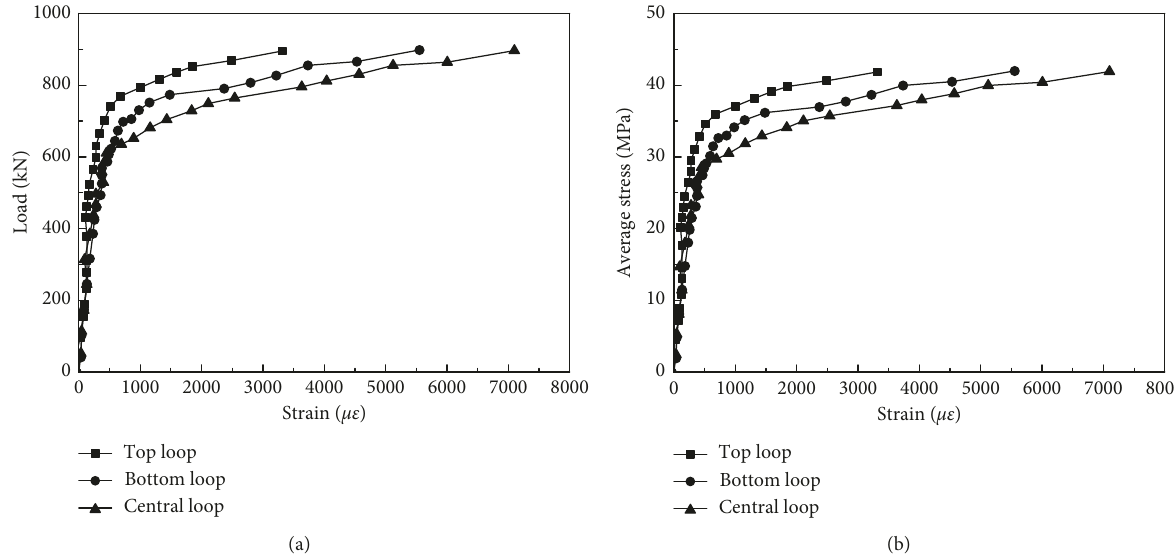
Figure 12: Loop strain development of specimen RS-A-2 with steel casing. (a) Relationship of loop strain development with load. (b) Relationship of loop strain development with average